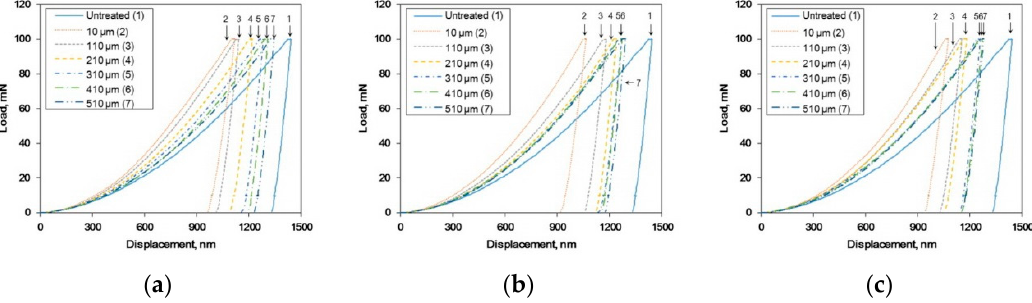
Figure 9. The effect of the static load in UNSM treatment on the representative load-displacement curves of Alloy 600 by nano-indentation: ( a ) 10 N; ( b ) 30 N; ( c ) 50 N.